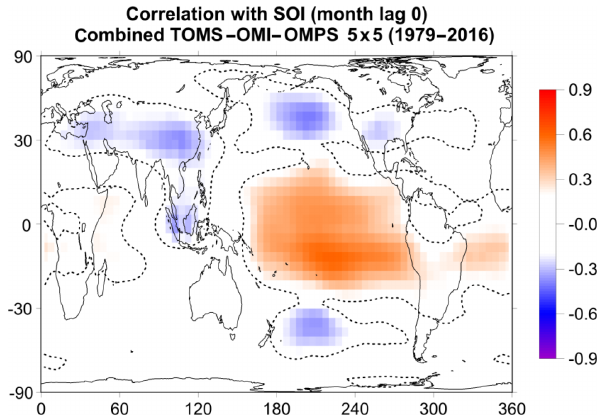
Figure A1. Map of correlation coefficients between total ozone from TOMS–OMI–OMPS satellite data and SOI for the whole period 1979– 2016, after removing variability related to the seasonal cycle, QBO, and solar cycle. The dotted line binds the regions where the correlation coefficients are statistically significant at the 99% confidence level ( t test). Only correlation coefficients above or below ± 0 . 2 are shown. Ozone data for the period 1991–1993 after the Mt Pinatubo eruption were not used in the correlation analysis to avoid any data contamination by the volcanic aerosols.